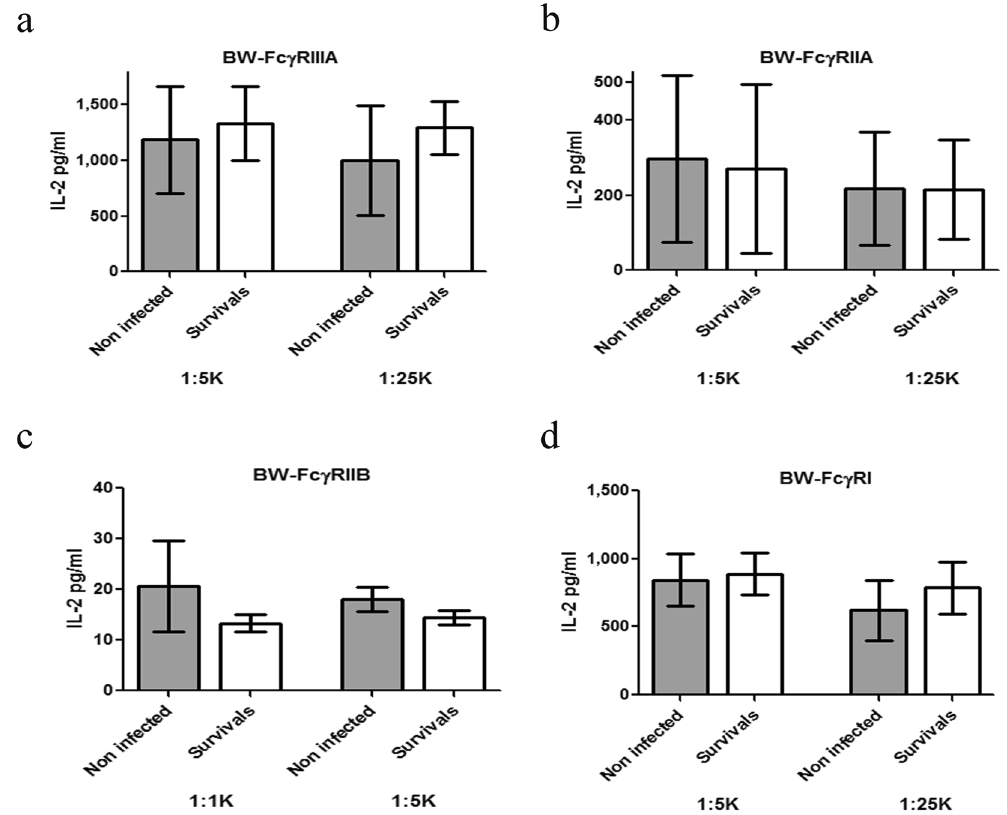
Figure 2. Binding and activation of the reporters by sera from survivors of SUDV outbreak. Total IgG dependent activation through Fc γ Rs with goat- anti human IgG. After pre-coating with goat-anti human IgG (2 µ g/ml) the activation assay was performed (as described in the legend of Fig. 1) using a total of 14 non- infected and 14 survivors’ serum samples (including 5 serum samples from a longitudinal study for the GP-Gulu specificity). 1:1 K and 1:5 K sera dilution was used for BW-Fc γ RIIB response, and 1:5 K and 1:25 K for BW-